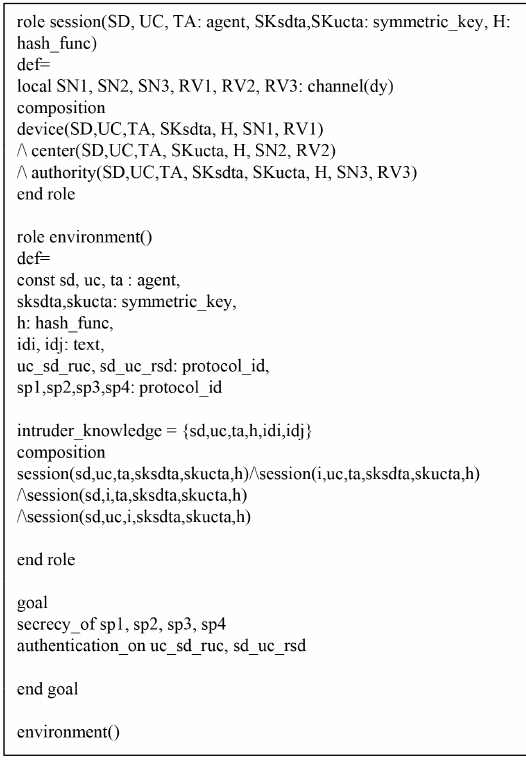
Figure 9. Role specification of environment and